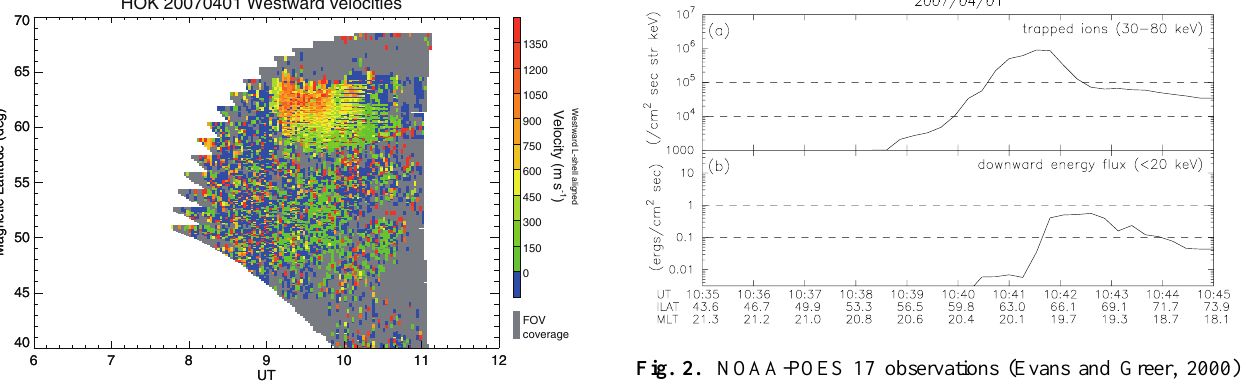
Fig. 2. NOAA-POES 17 observations (Evans and Greer, 2000) crossing over the westward flow enhancement on 1 April 2007: (a) trapped ions of 30–80keV observed by MEPED and (b) down- ward electron energy flux of < 20keV observed by TED. The hori- zontal dotted lines are used as the threshold values if intersected at clear